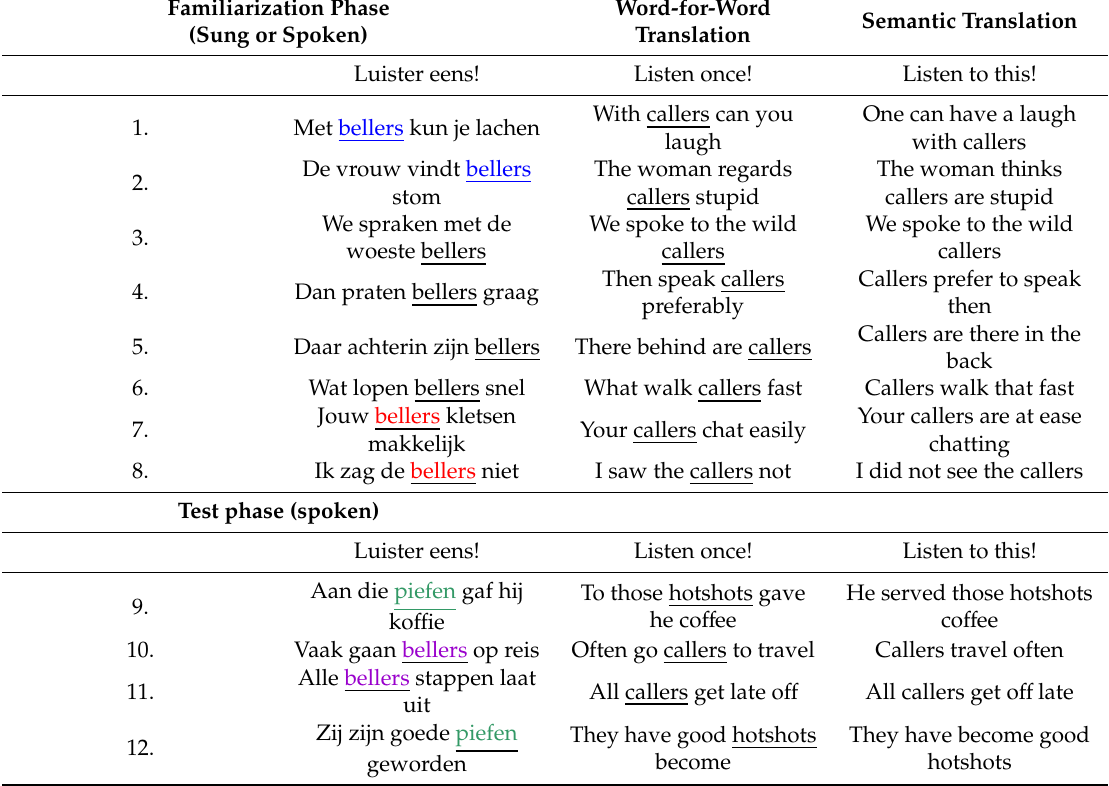
Table 1. Example of a familiarization + test block with target word pair bellers-piefen. Target words are underlined. Materials were in Dutch. English word-for-word and semantic translations are given. The first two (first / second) target occurrences are indicated in blue, the last two (seventh / eighth) target occurrences of the familiarization phase are indicated in red. Familiarized target words in the test phase are indicated in purple, and novel control words are indicated in